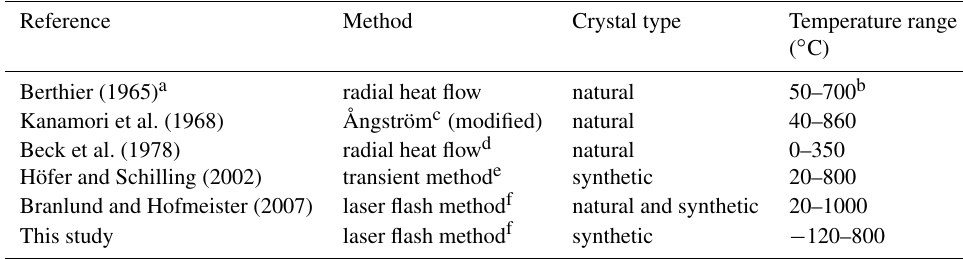
Table 1. Published data on thermal transport properties of single-crystal quartz in the [001] and [100] directions.